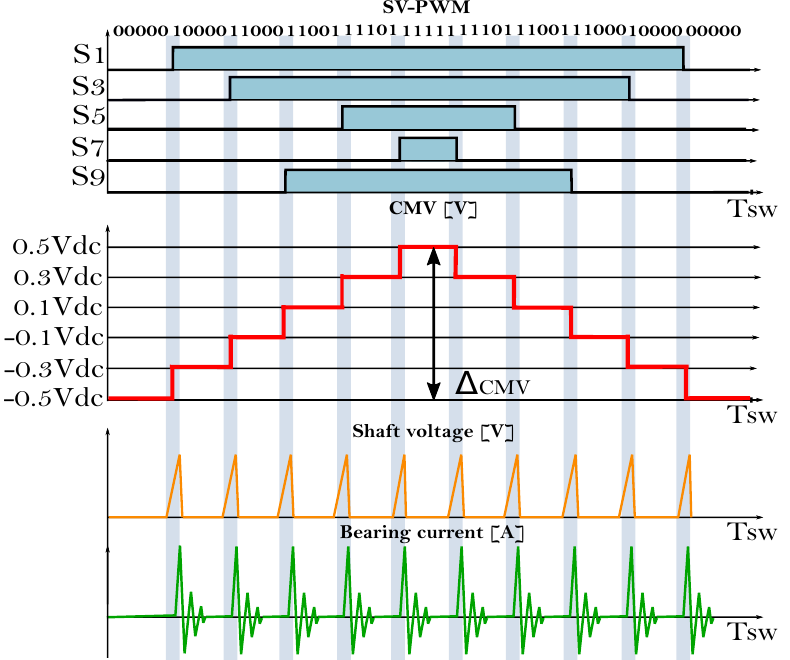
Figure 4. CMV waveform of SV-PWM technique (adapted from